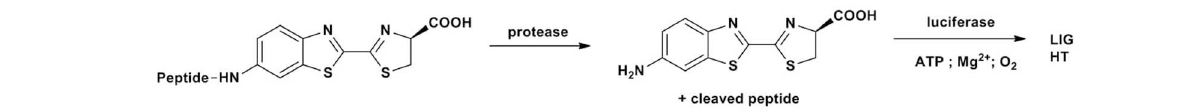
(Supplementary Figure 3), TLC: n -hexane/dioxane = 2:1; R f :